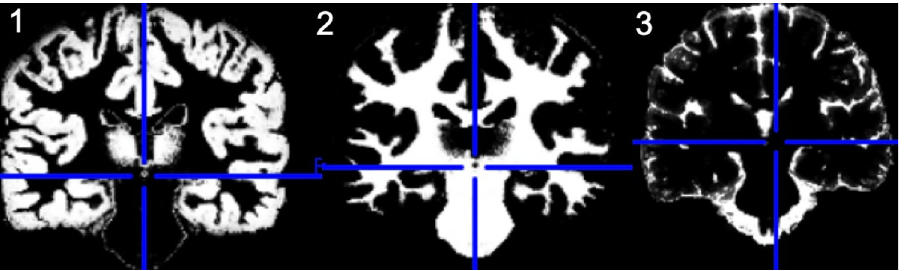
Fig 2. Brain segmentation. Coronal view of T1 weighted image segmented into 1) grey matter, 2) white matter and 3) cerebrospinal fluid.